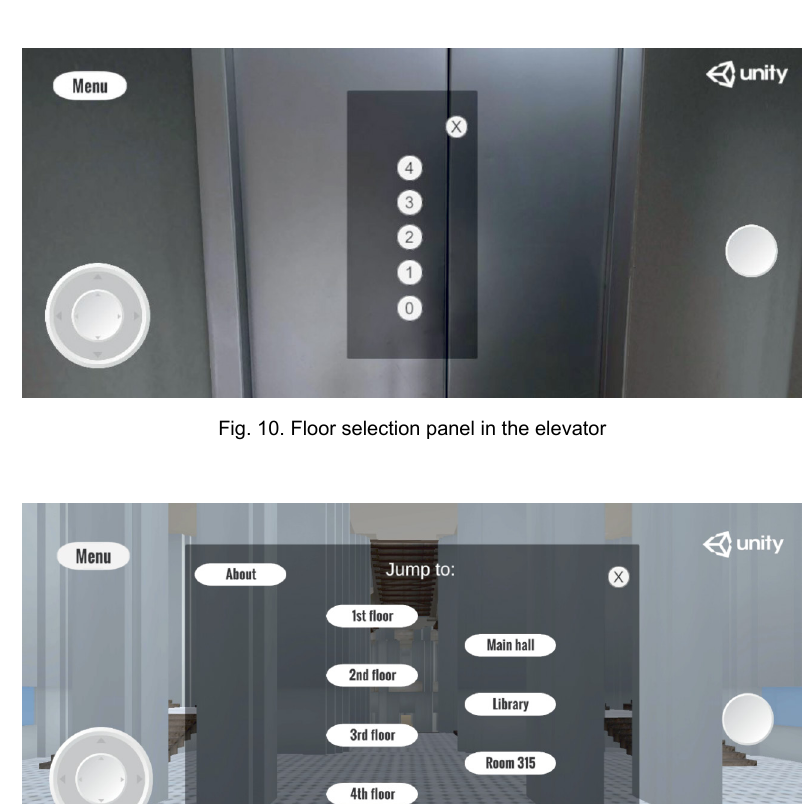
Fig. 9. Navigation in the application